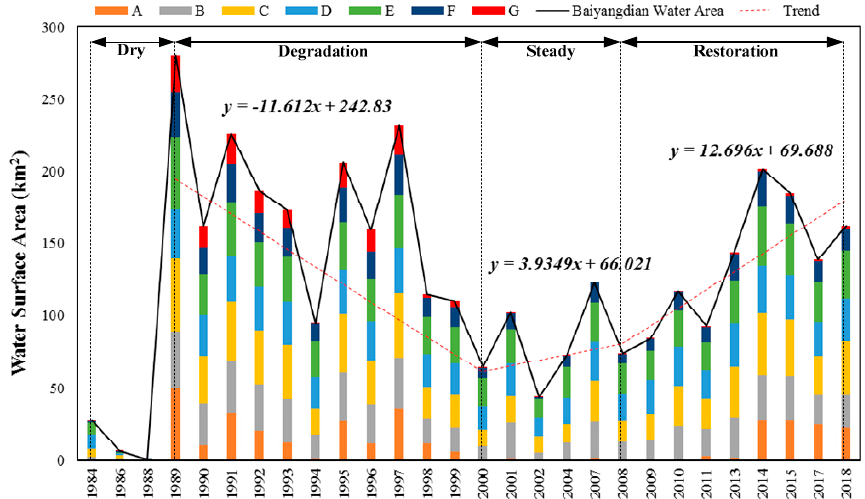
Figure 11. Water area changes in Baiyangdian Lake and 7 subregions from 1984 to 2018.